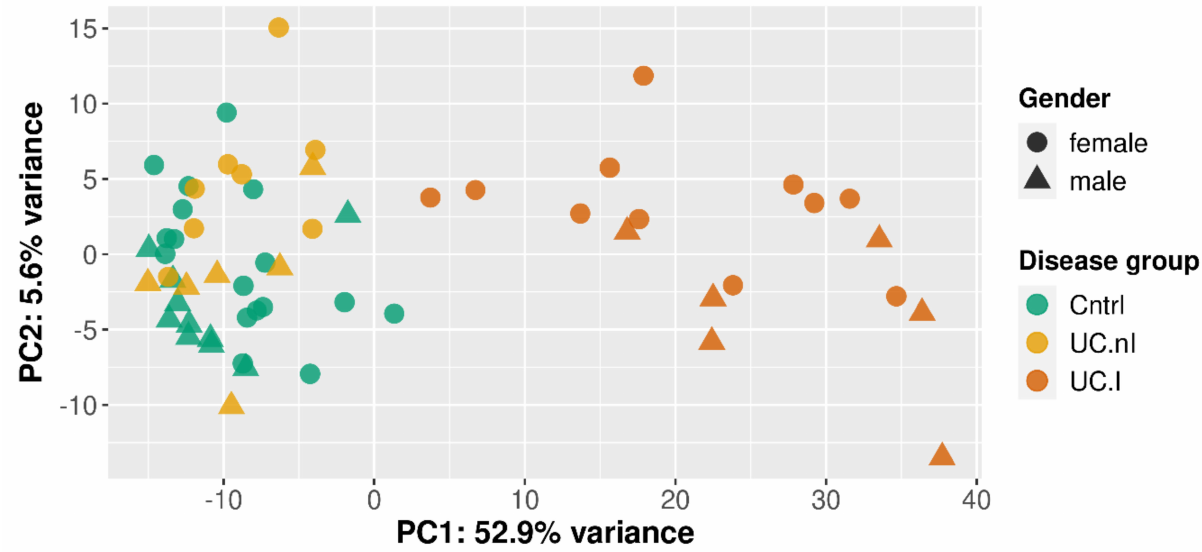
Figure 1. Visualization of disease groups and gender using the first (PC1) and second (PC2) principal component of the 500 genes with the highest variance. Disease groups were inflamed UC mucosa (UC.I), non-inflamed UC mucosa (UC.nI), and non-inflamed, non-IBD controls (Cntrl). Additionally, along the second principal component, control mucosa differed from both inflamed ( p = 4.07 × 10 − 2 ) and non-inflamed UC mucosa ( p = 2.68 × 10 − 2 ). A gender associated difference in gene expression was observed in the second di- mension for inflamed UC mucosa (6 males and 11 females; p = 5.82 × 10 − 3 ), but not for non-inflamed UC mucosa (6 males and 8 females) or control mucosa (10 males and 17